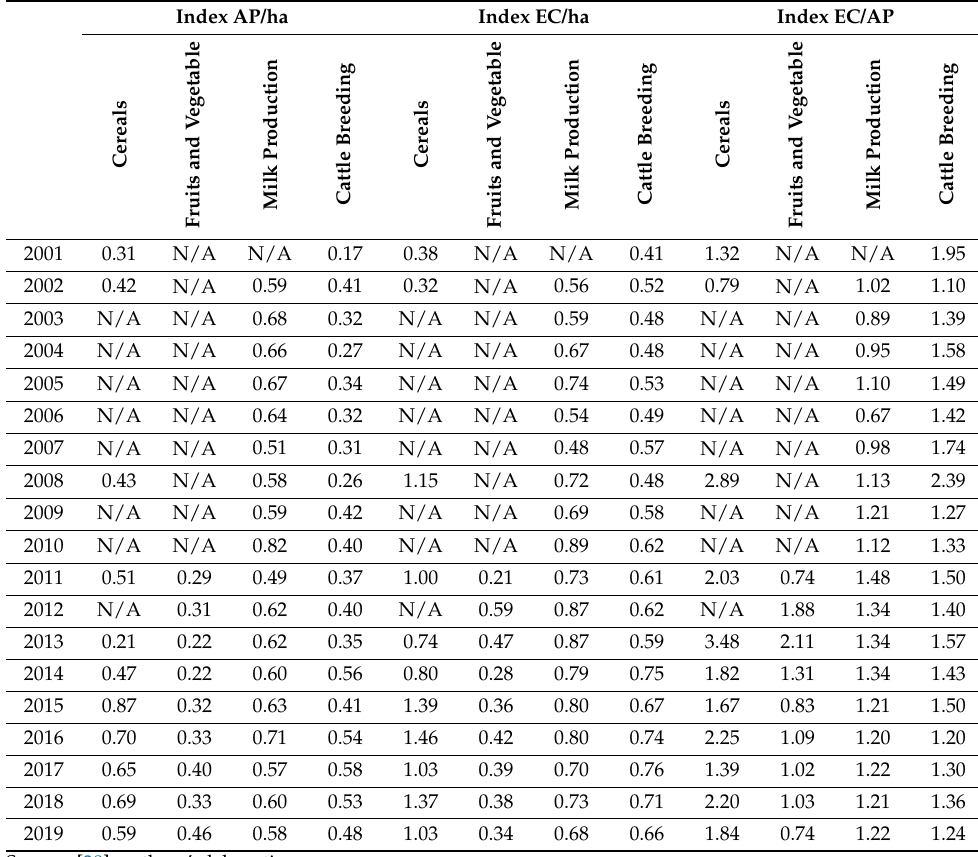
Table 3. Performance (AP) and direct energy consumption (EC) in different types of production orientation of farms in organic and conventional